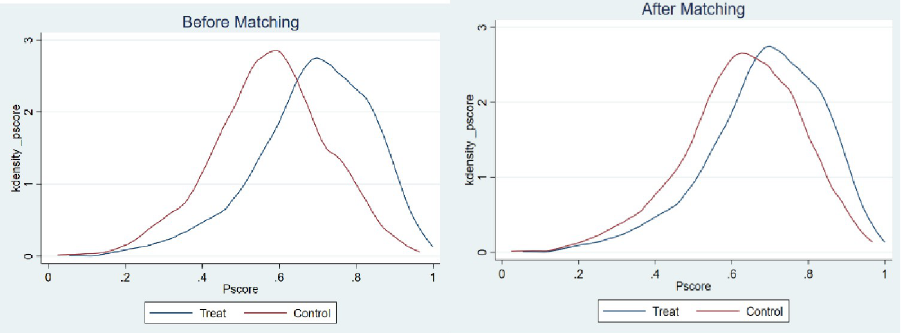
Fig 3. Y2: Comparison of the PS probability values between “rural households who participated in the appraisals” and “rural households who did not participate in the appraisals” before and after nearest neighbor matching.